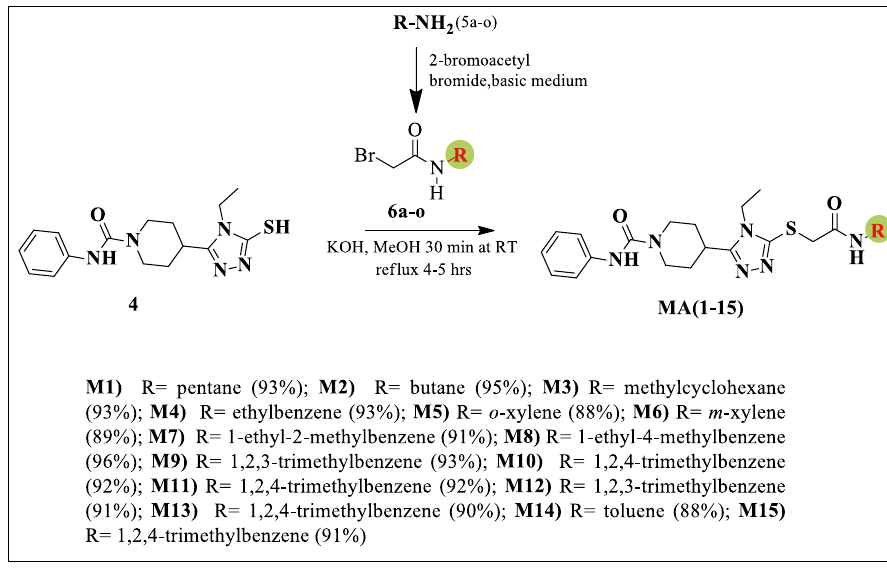
Figure 2. Synthesis of phenylcarbamoylpiperidine-1,2,4-triazole amide derivatives 39 .